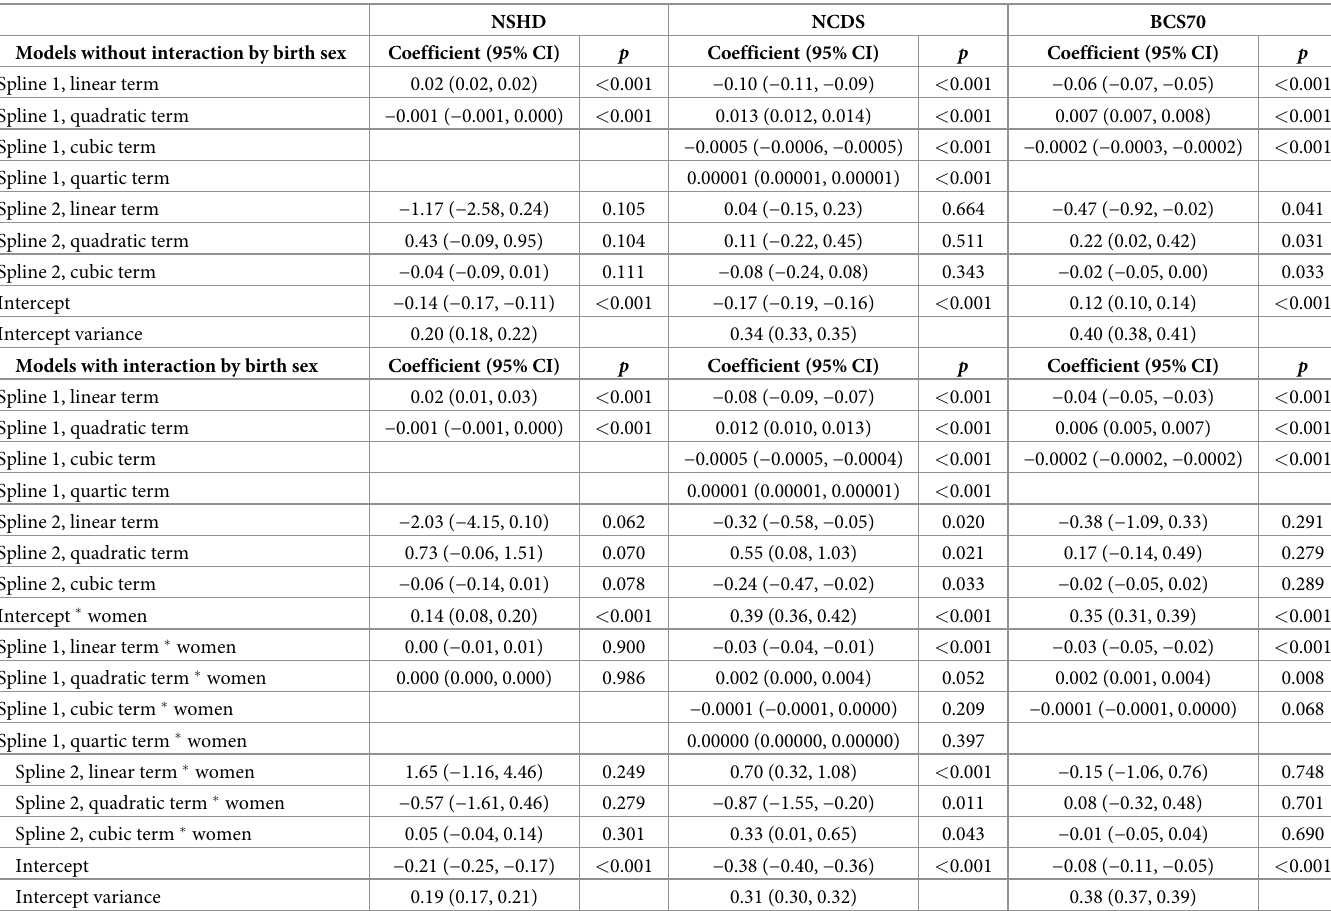
Table 2. Model coefficients from the multilevel growth curve models with cross-cohort factor scores as outcome (linear